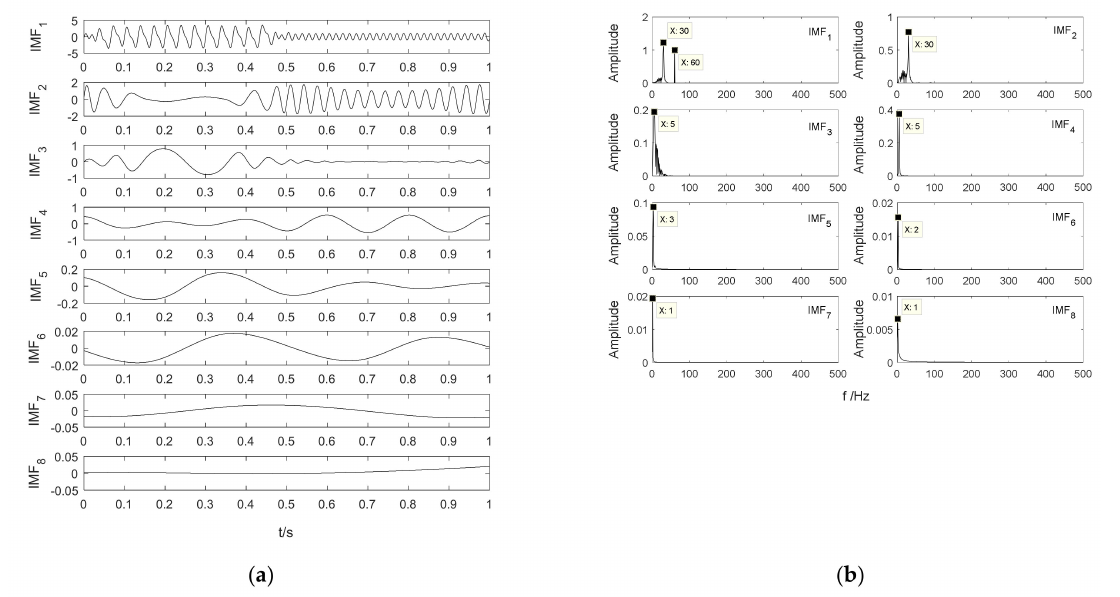
Figure 7. The decomposition results of empirical mode decomposition (EMD). ( a ) Time domain; ( b ) Frequency